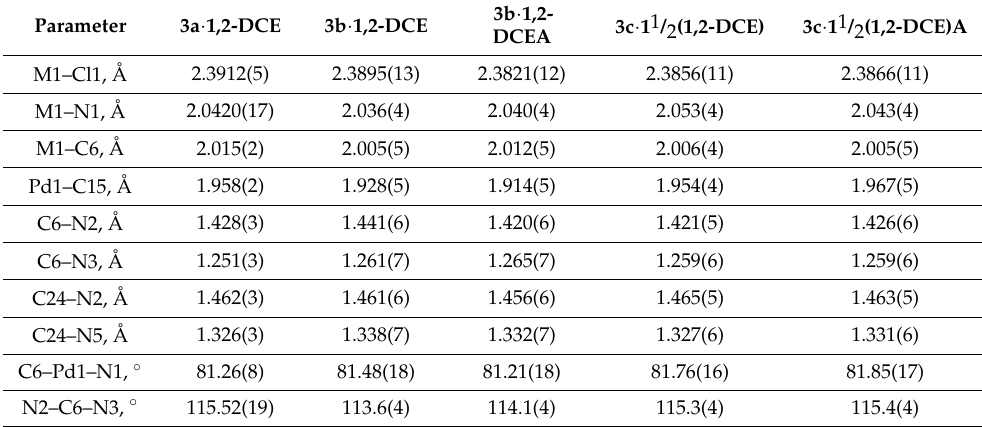
Table 1. Selected bond lengths and angles for complexes 3a–c in the obtained